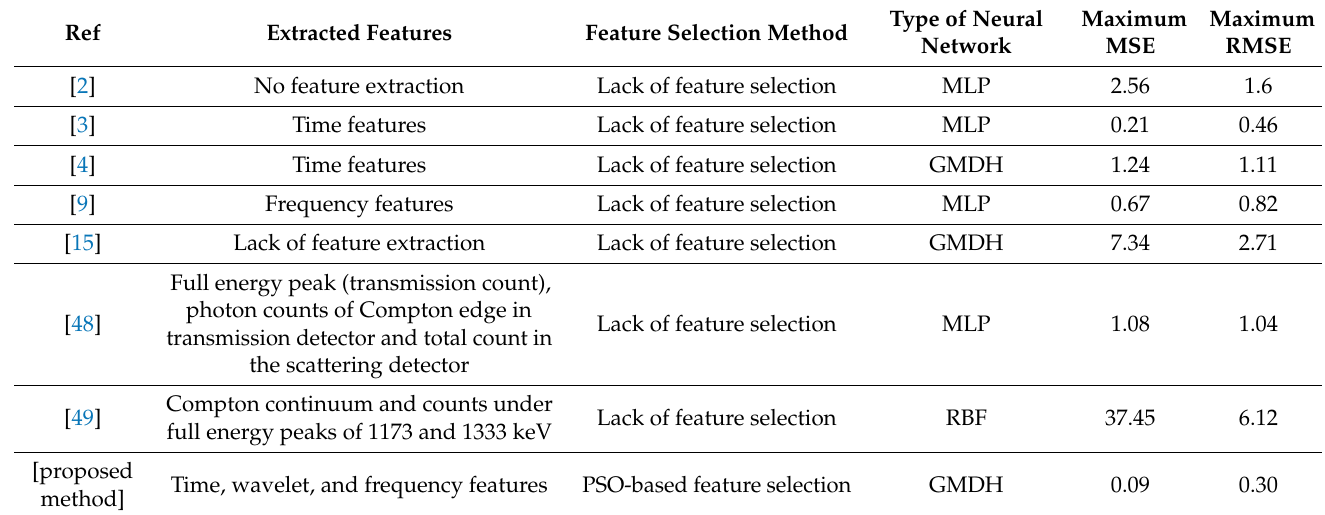
Figure 10. Regression and error histogram plots for ( a ) training and ( b ) testing data. Table 1. A comparison of the accuracy of the proposed detection system and previous studies.